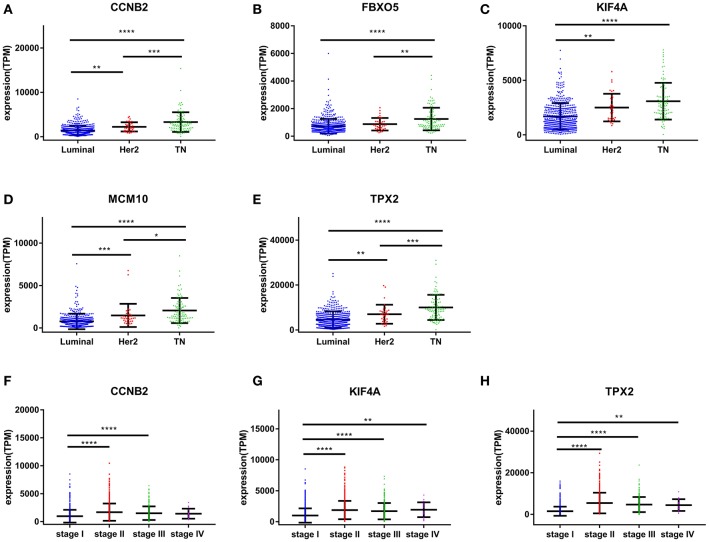
Validation of CCNB2, FBXO5, KIF4A, MCM10, and TPX2. (A) The correlation of CCNB2 (A), FBXO5 (B), KIF4A (C), MCM10 (D), and TPX2 (E) expression with breast cancer molecular subtypes. (F) The correlation of CCNB2 expression with pathological stage. (G) The correlation of KIF4A expression with pathological stage. (H) The correlation of TPX2 expression with pathological stage.*P < 0.05; **P < 0.01; ***P < 0.001; ****P < 0.0001. One-way analysis of variance (ANOVA) was used to evaluate the statistical significance of differences.